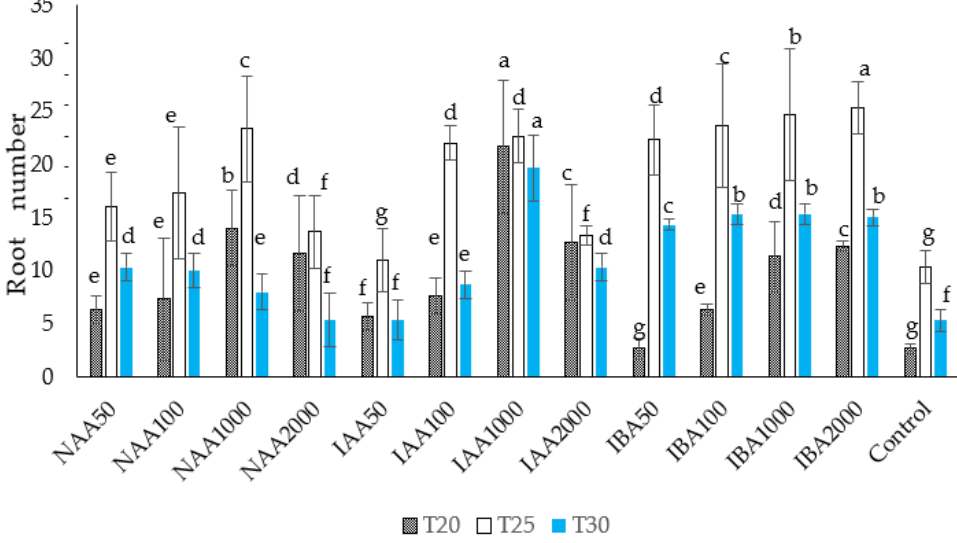
Figure 3. The effect of auxin concentration on average root number in C. indicum. Different letters indicate statistical differences as assessed by Duncan’s multiple comparison tests ( p < 0.05).